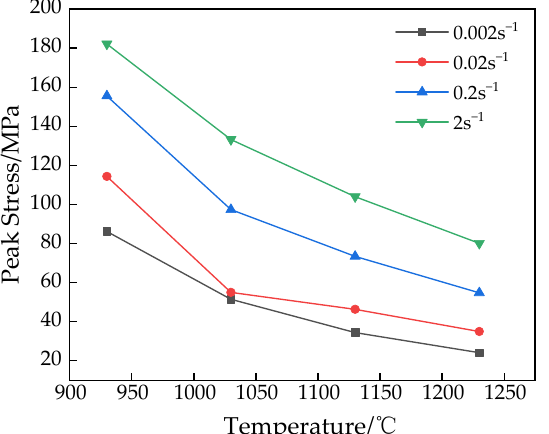
Figure 3. Variation of peak stress with temperature corresponding to different strain